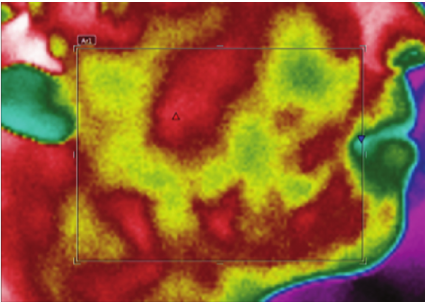
Figure 16: Temperature measurement of a face at normal tempera- ture.